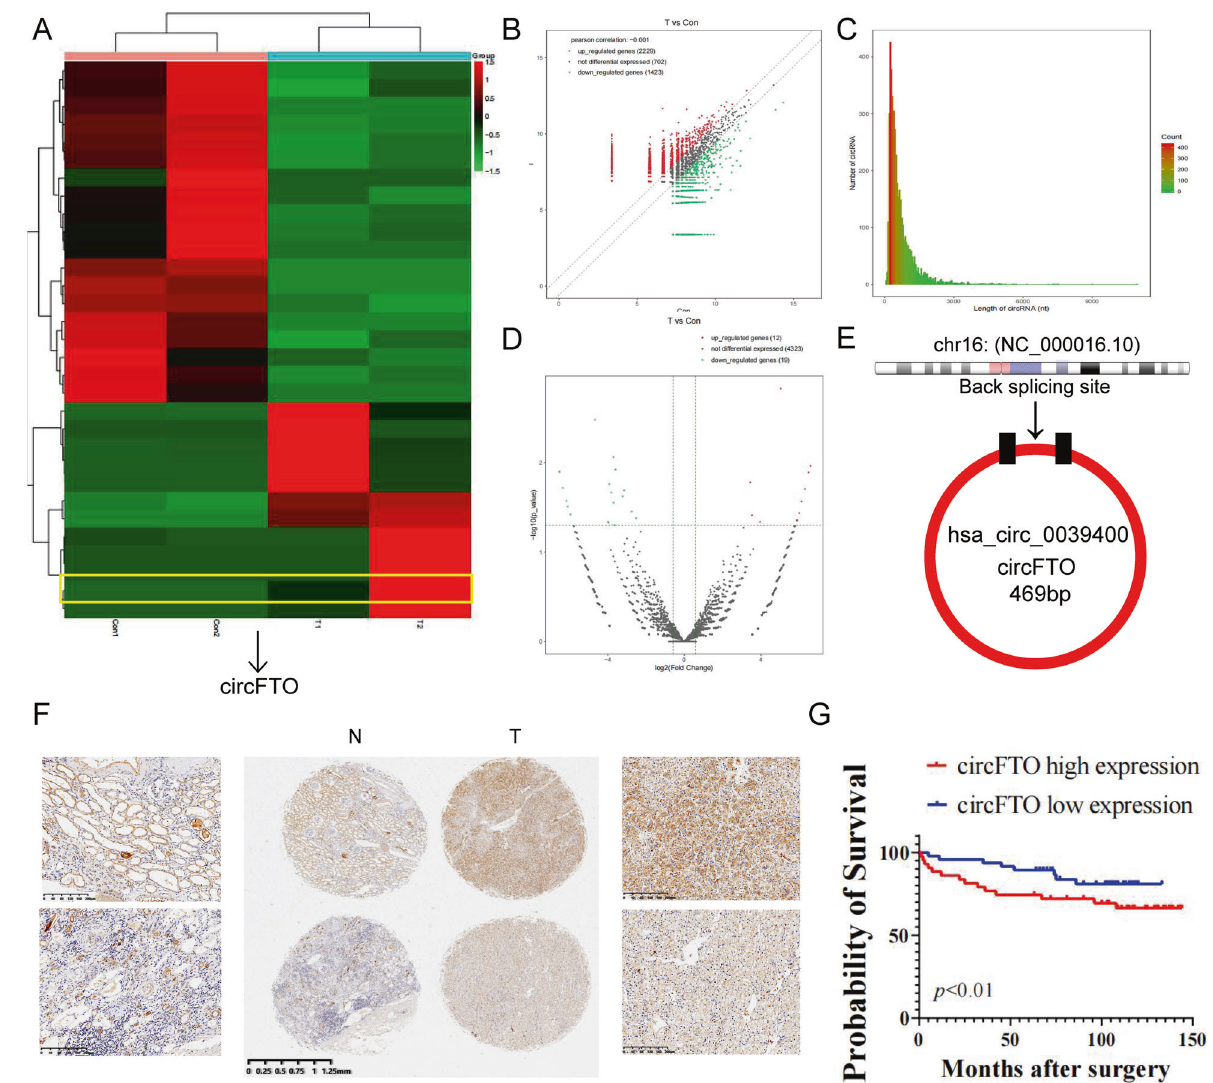
Fig. 1 circFTO is up regulated in ccRCC and correlated with worse prognosis. A Heatmap of signi fi cant differential expressed circRNAs between tumor and normal tissue in ccRCC. B Scatterplots of differential expressed circRNAs between tumor and normal tissue. C Distribution of length of identi fi ed circRNAs. D Vocano plot of signi fi cant differential expressed circRNAs. E Genomic loci of FTO gene and circFTO. F Expression of circFTO in tumor and normal tissue identi fi ed by RNA in situ hybridization (ISH). G Prognostic signi fi cance of circFTO expression for ccRCC patients determined with ISH values. Median value was used as the